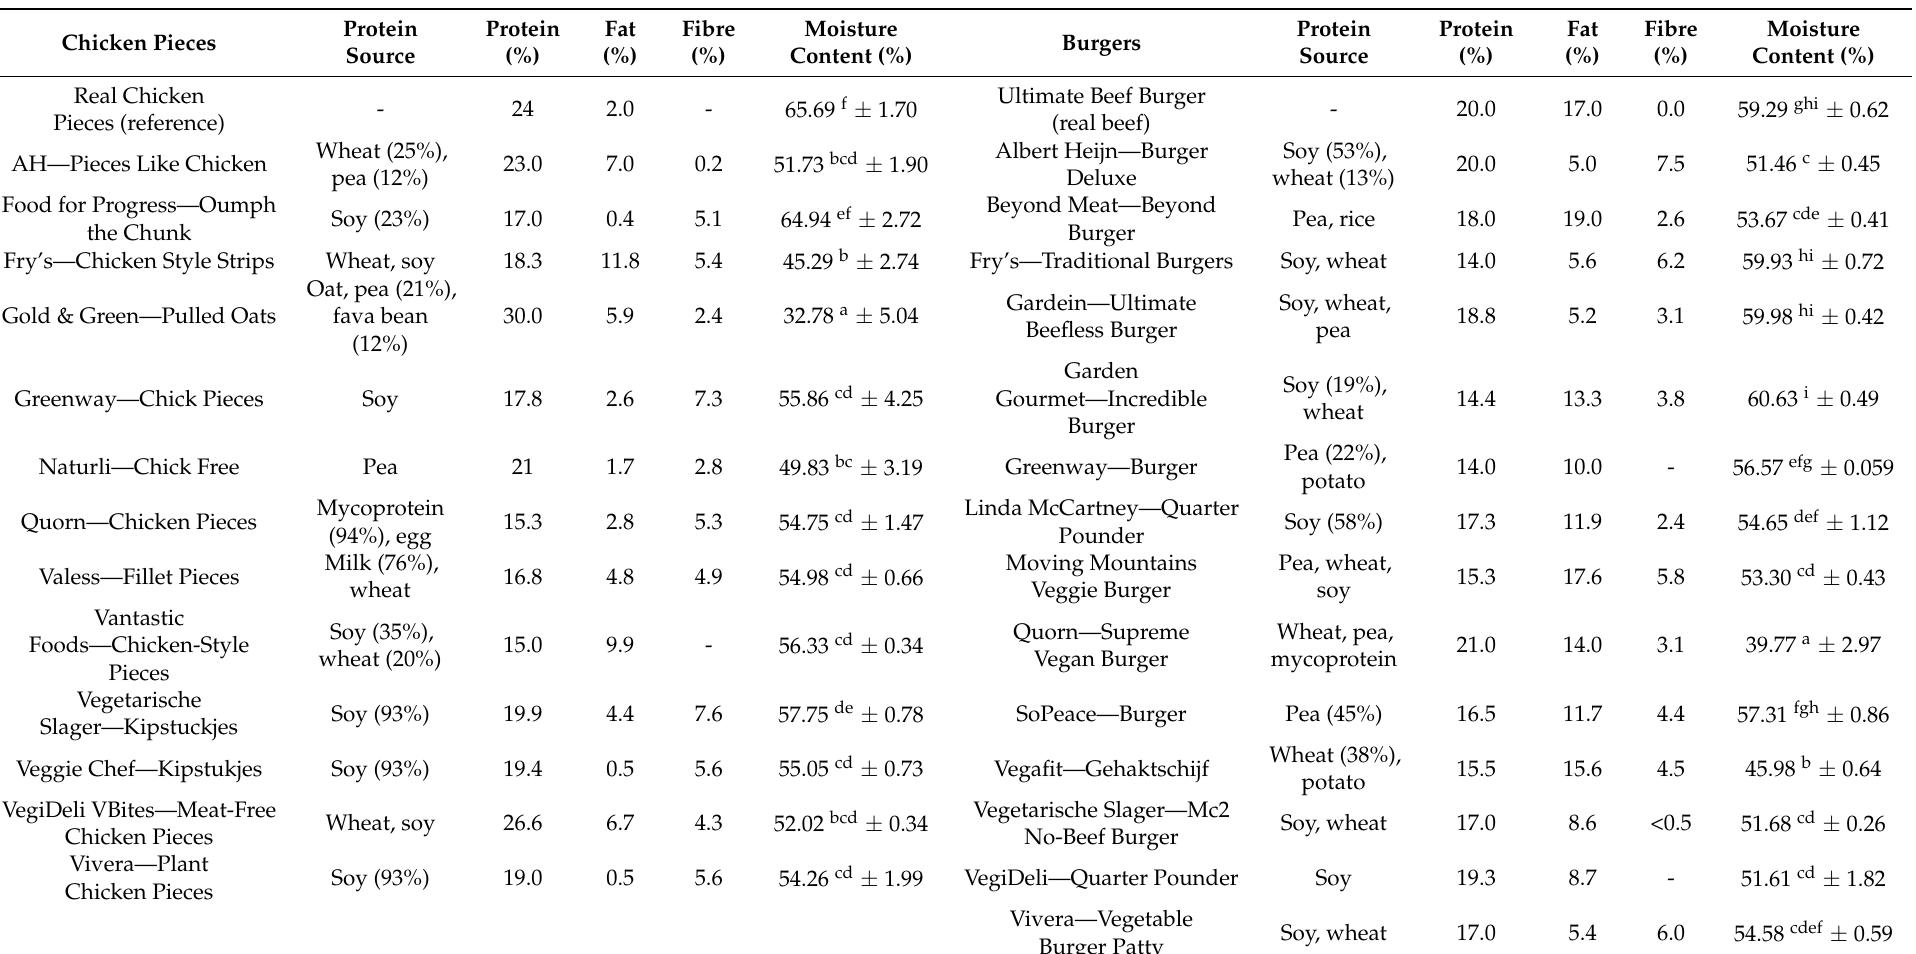
Table 2. Selected meat analogue chicken pieces and beef burgers, with corresponding protein sources, protein content (%), fat content (%), fibre content (%), and moisture content (%).